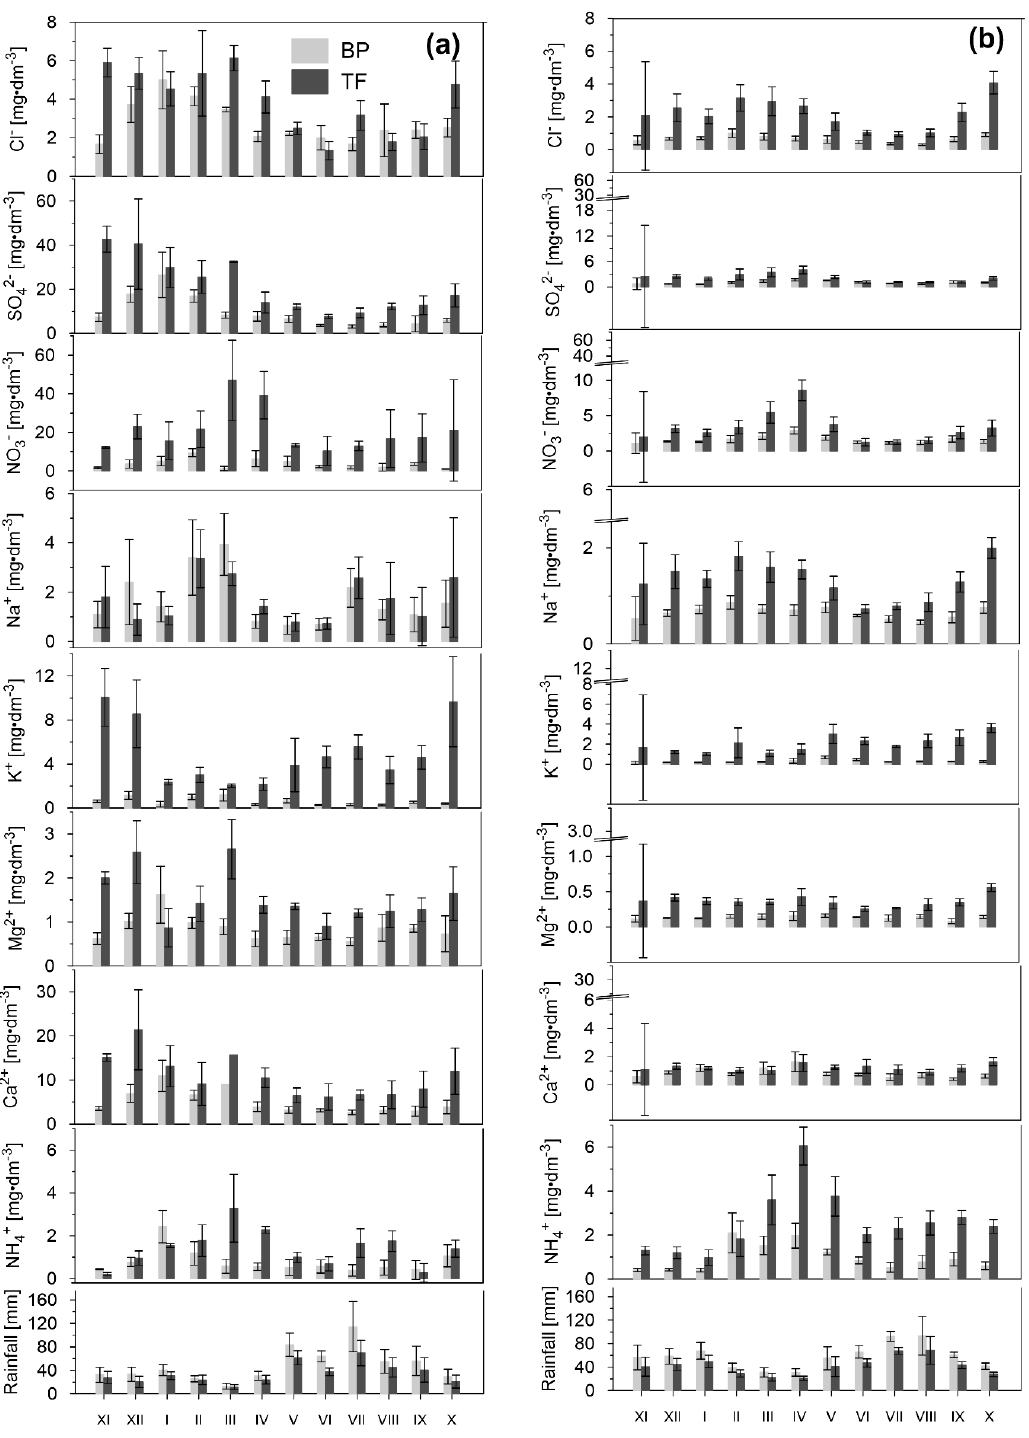
Figure 4. Monthly variation of volume-weighted mean ± standard error ion concentrations in bulk precipitation (BP) and throughfall (TF) in Malik ( a ) and in Czarne ( b ). For comparison, monthly rainfall is presented at the bottom of the graph as well.